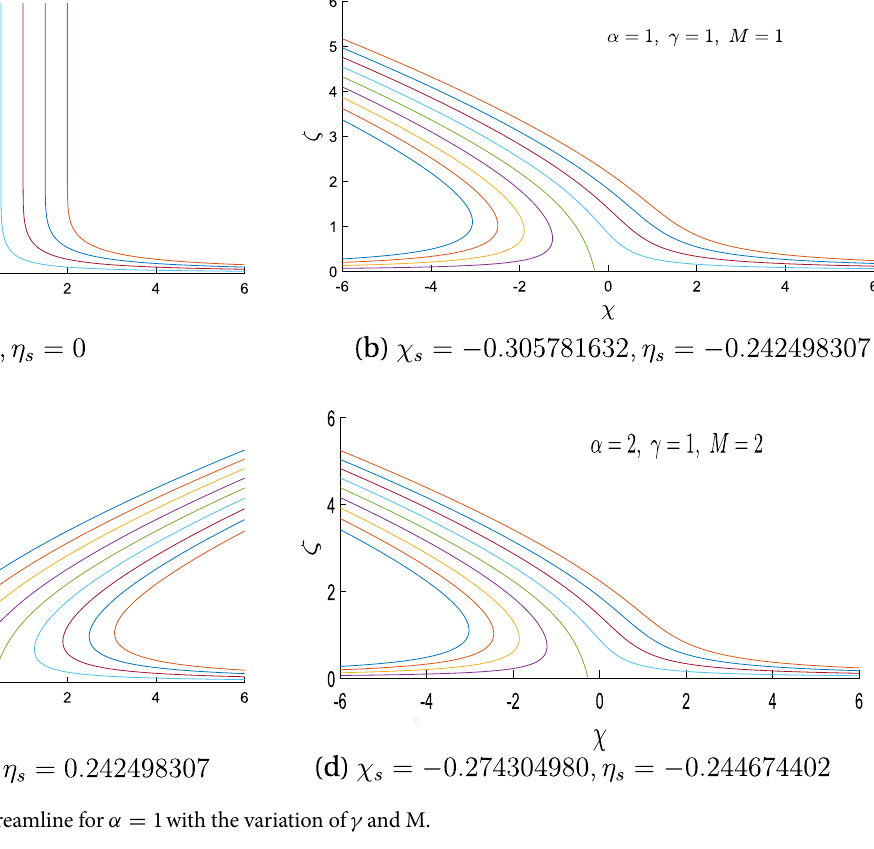
Figure 5. Streamline for α = 1 with the variation of γ and M.